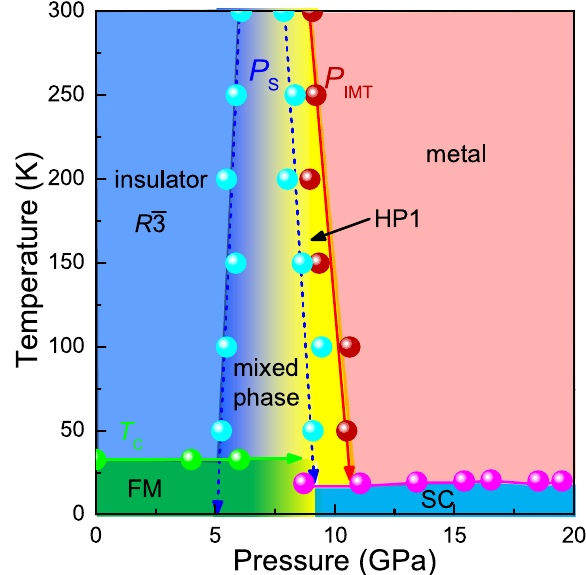
Fig. 3 Phase diagram of CrSiTe 3 . Temperature – pressure phase diagram summarizing the structural, magnetic, and electronic properties of CrSiTe 3 . The beginning and end of the structural phase transition as well as the position of the insulator – metal transition are determined from the spectroscopic results discussed here. The Curie temperature and the superconducting transition temperature (×5) as a function of pressure are from ref. 27